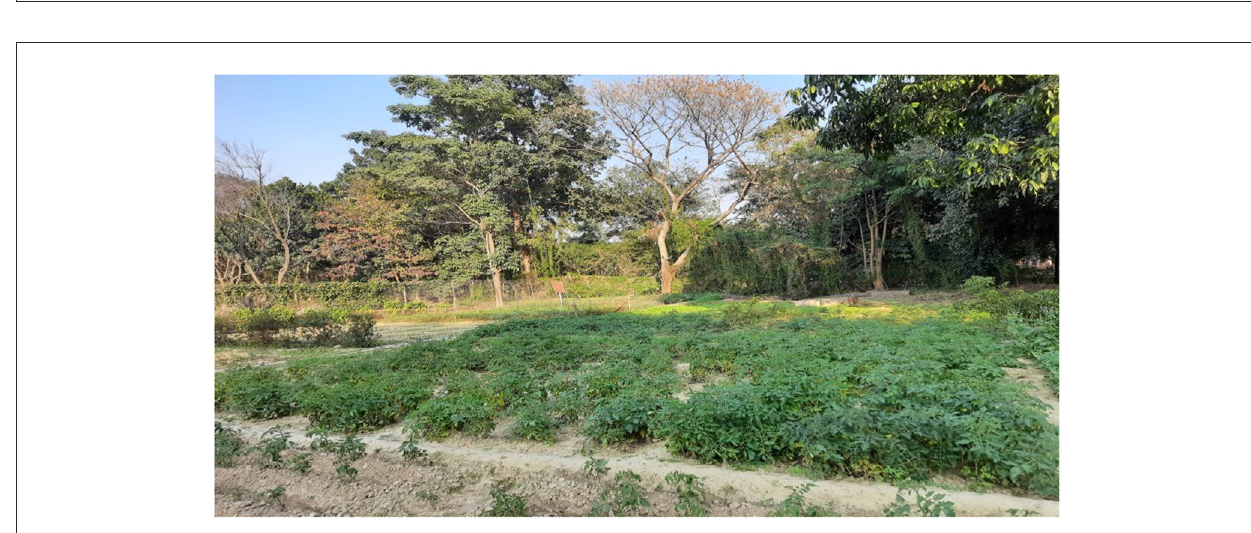
biological process for large-scale manufacturing. It is feasible that a deterioration in membrane integrity led to the antifungal activity observed in this study. The findings from the field investigation